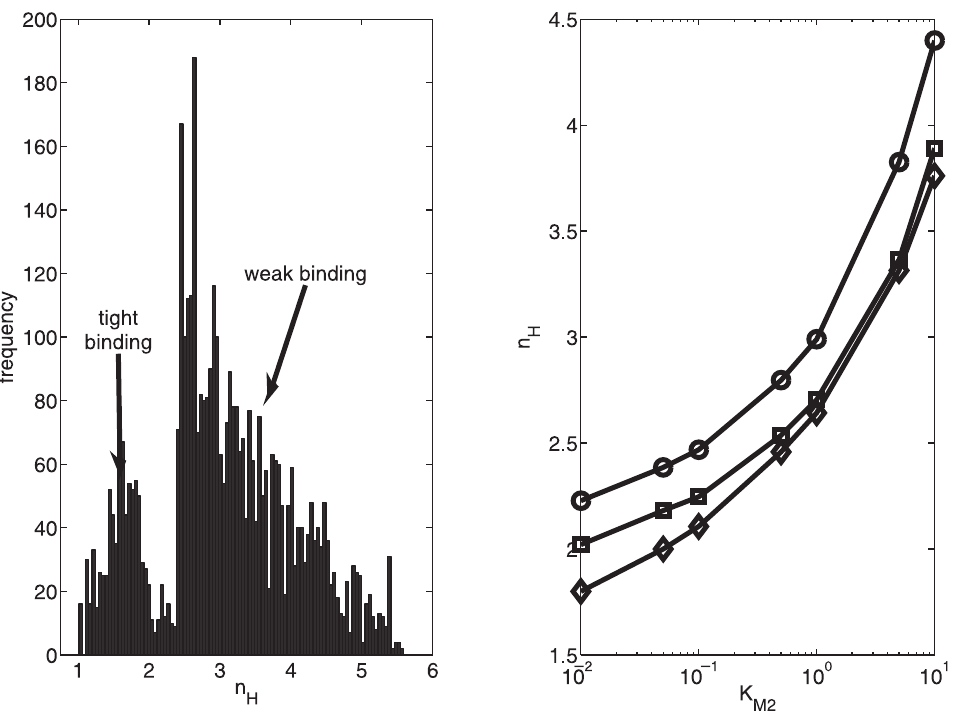
Figure 4. Dependence of the Hill coefficient on Michaelis-Menton binding constants in the canonical MAPK pathway. (left) Spread of Hill coefficients calculated from model (1). Exponents for binding and kinetic constants for MAPK and MAPKK were drawn from a uniform ( 2 3,3) distribution. (right) Representative Hill plots for model (1). Kinetic constants are k 1 c ~ k 2 c ~ 1 . Lines represent K M ,1 ~ 0 : 01 (diamonds), K M ,1 ~ 0 : 1 (squares), and K M ,1 ~ 1 (circles).